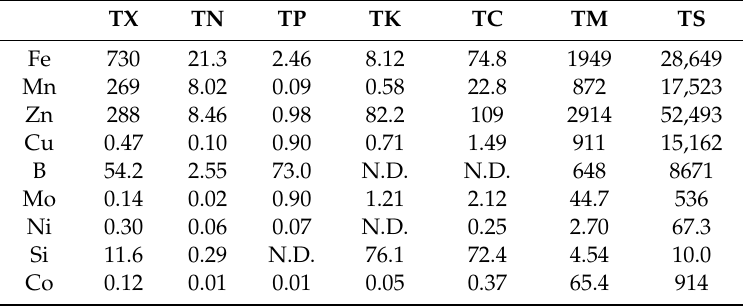
Table 2. Concentration (mg / L) of micronutrients in the MCT ® fertilizer